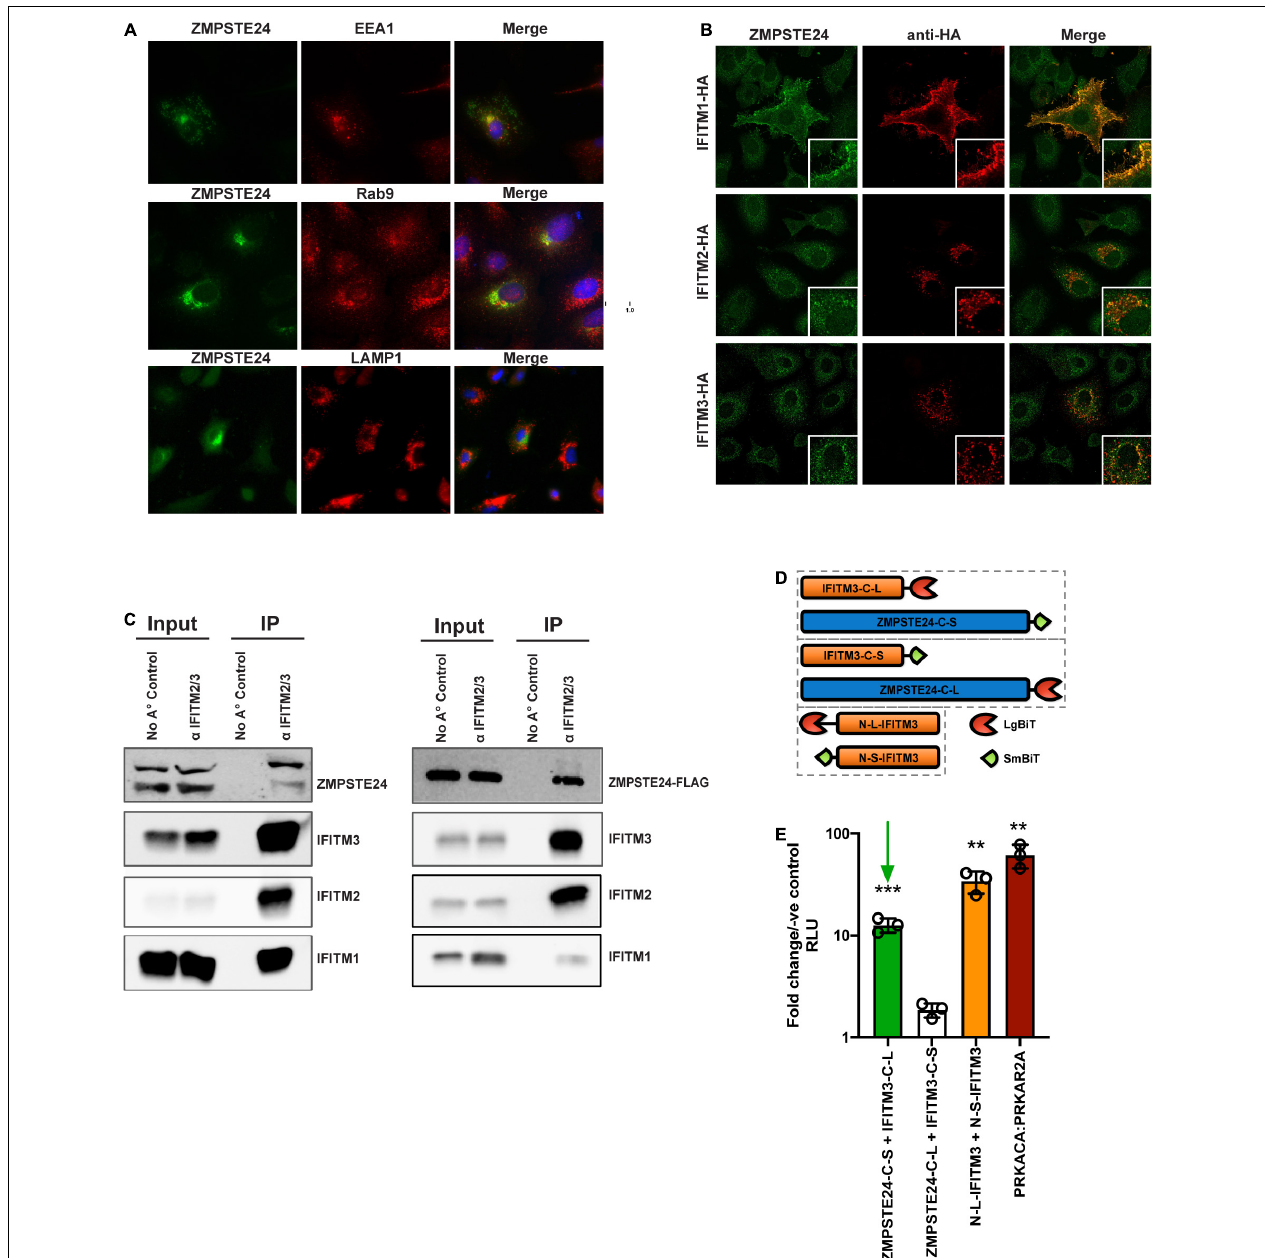
FIGURE 3 | ZMPSTE24 colocalises with IFITM proteins and interacts via a C-terminal interaction with IFITM3. (A) ZMPSTE24 is localised to early and late endosomal compartments. ZMPSTE24-HA was transiently expressed in A549 cells which were then probed with antibodies against HA, early endosomal (EEA1) or late endosomal (Rab9) markers, or LAMP1. Nuclei were counterstained with DAPI. Panels are of representative images. Pearson’s correlation coefficient of ZMPSTE24 with the early and late endosomal compartment markers was calculated by measuring cells of interest using ImageJ software. (B) A549 cells transiently expressing HA-tagged IFITM proteins 1, 2, and 3 were probed with antibodies against endogenous ZMPSTE24 and HA and imaged by confocal microscopy. Panels are of representative images. Pearson’s correlation coefficient of ZMPSTE24 with individual IFITM proteins was calculated by measuring cells of interest using ImageJ software. (C) For the endogenous IP, A549 cells were pre-treated with IFN prior to cell lysis. For the co-IP, IFN pre-treated A549 cells were mock-transfected or transfected with ZMPSTE24-FLAG. Cell lysates were immunoprecipitated with anti-IFITM2/3 monoclonal antibody prior to resolving by SDS-PAGE and analysis by western blotting for endogenous ZMPSTE24 or ZMPSTE24-FLAG along with IFITMs 1, 2, and 3. (D) Schematic illustration of NanoBiT construct expression. IFITM3 or ZMPSTE24 were fused to large (LgBiT) or small (SmBiT) subunits of NanoLuc luciferase at N or C terminals and co-transfected in pairs (hatched boxes) into HEK293T cells. (E) Luminescence produced by interaction of co-expressed NanoBiT pairs was measured in live cells and analysed relative to a control consisting of the target-LgBiT co-transfected with a HaloTag-SmBiT control. LgBiT-PRKACA and SmBiT-PRKAR2A were co-transfected as a positive control. Green arrow indicates interaction between ZMPSTE24-C-SmBiT and IFITM3-C-LgBiT. Data are shown as mean ± SE (standard error) of n = 3 independent experiments. Significance is indicated as p -values *** p < 0.0001, ** p < 0.001.